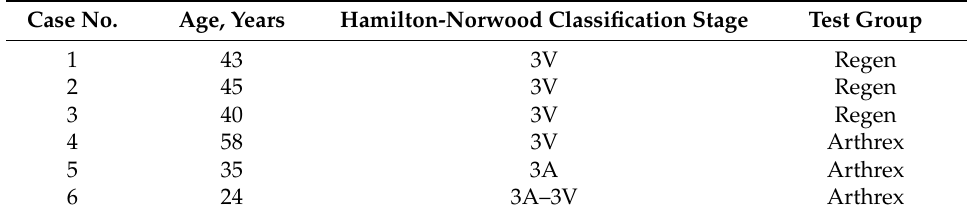
Table 5. Summary of AA-PRP treated patient